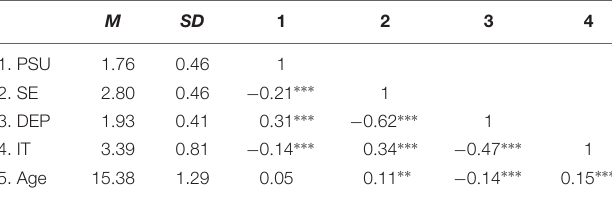
TABLE 1 | Descriptive statistics and correlations among